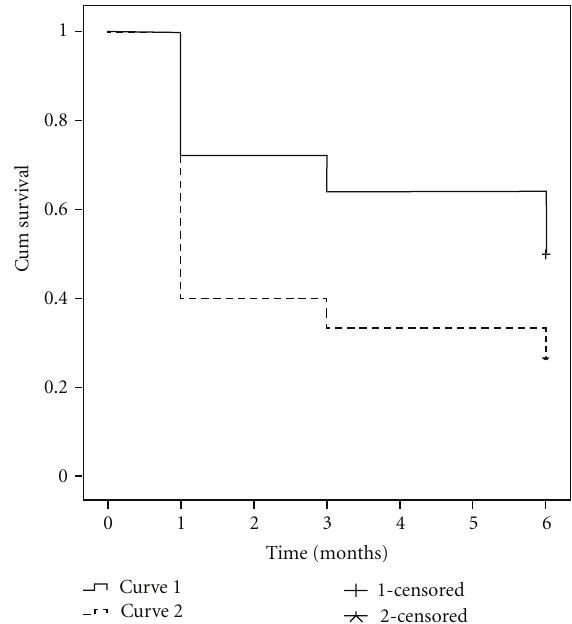
Figure 1: Kaplan-Meier survival curve for 66 eyes of 42 patients after 270 ◦ SLT treatment. Success was defined as an IOP reduction ≥ 20% from baseline without changing the antiglaucoma medica- tion with no need for further laser trabeculoplasty or glaucoma surgery.